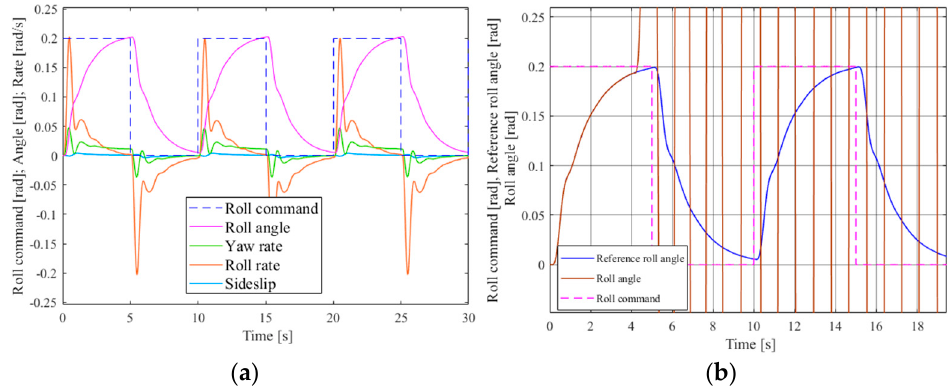
Figure 6. Performance responses of the FBW system: ( a ) the failure-free configuration; ( b ) the configuration of the “PFC random” failure mode.